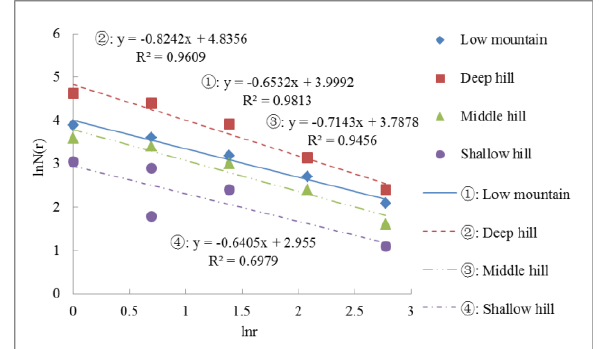
Figure 4. Fitting straight line of lnr-lnN(r) of landslide hazard points based on annual rainfall division